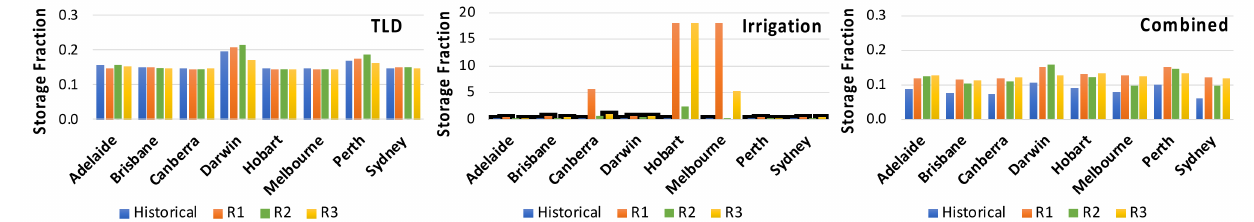
Figure 7. Storage fraction for all eight locations for both the historical and future period for TLD, irrigation and combined